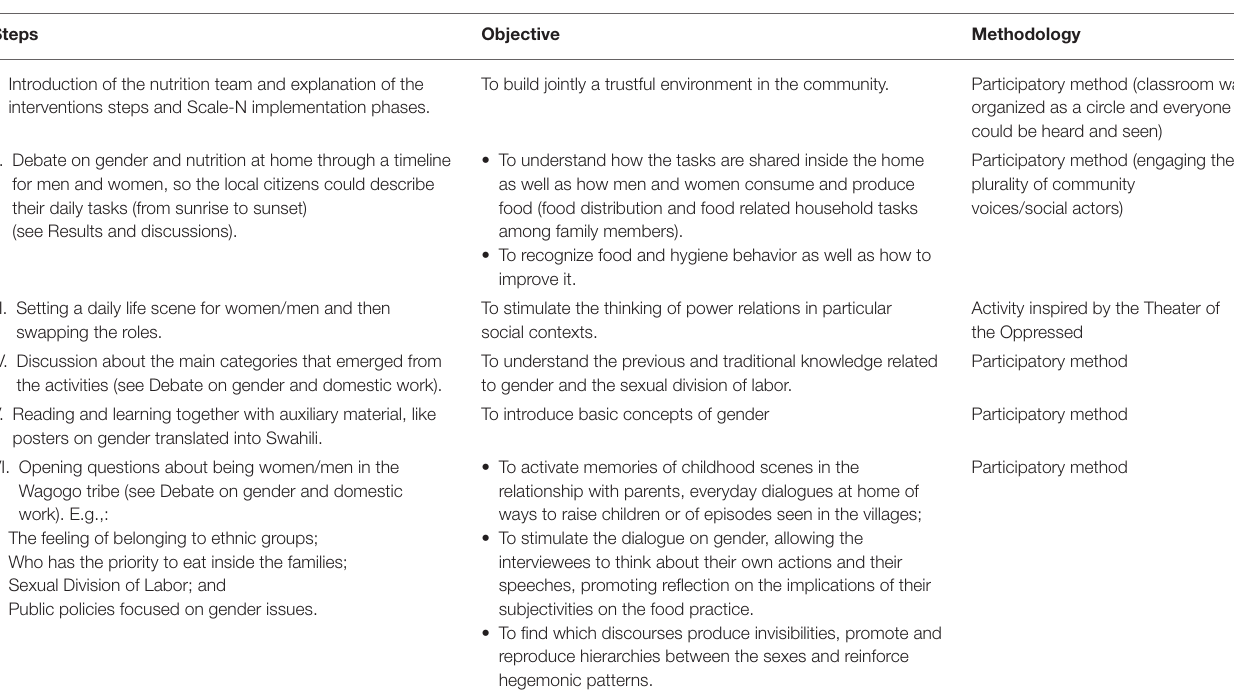
TABLE 1 | Steps, objectives, and methods combined during the nutritional